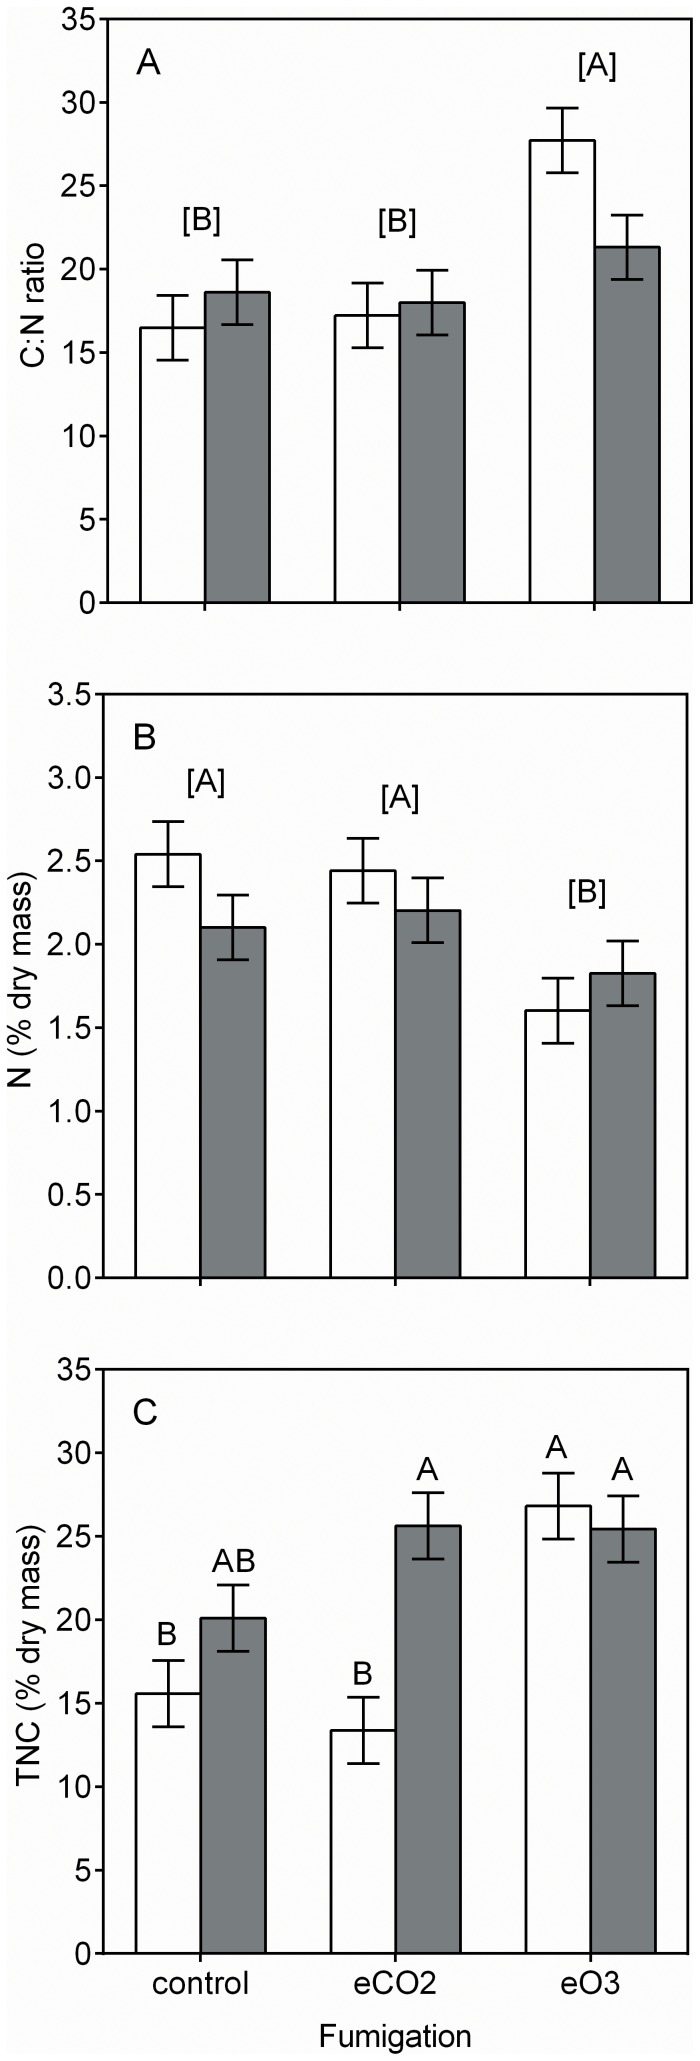
Fumigation and plant species effects on a) C:N, b) N, and c) TNC.White and gray bars indicate least square means ±SE (n = 3 replicate FACE rings for each group mean shown) for S. candensis and T. officinale, respectively. Significant differences between group means were analyzed using Tukey’s HSD post hoc test, where differences between group means are indicated by letters within brackets (e.g., “[A]”) for fumigation main effects, and pairwise comparisons among levels of fumigation and plant species are indicated by letters without brackets (e.g., “A”) when there were significant interaction terms from the main model.